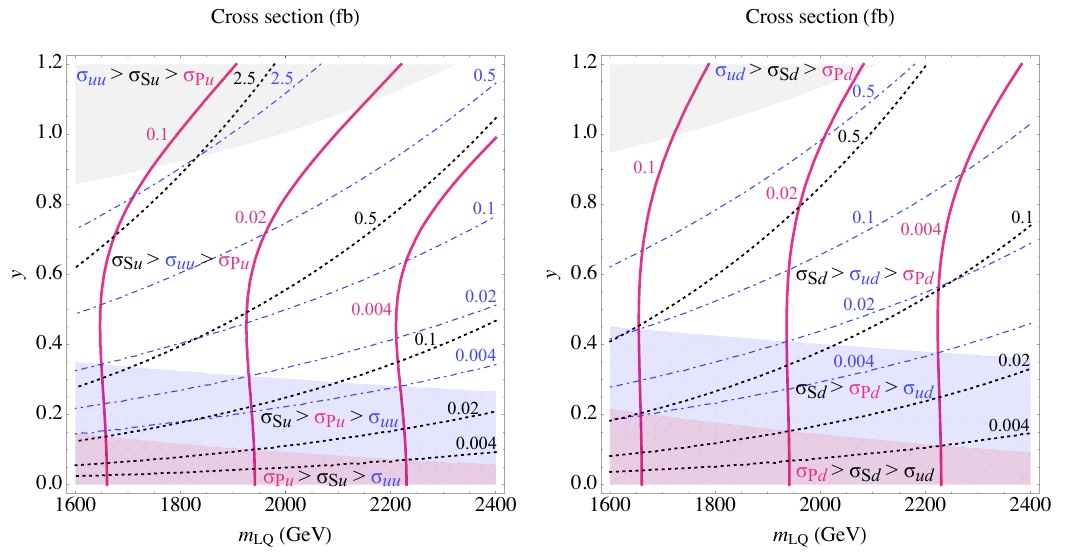
Figure 3 . The contours of constant value for the novel contributions ( σ pair ( σ ) and single leptoquark production ( σ P u ( P d ) coupling y . Colored regions correspond to the particular orderings of the cross sectional strengths.